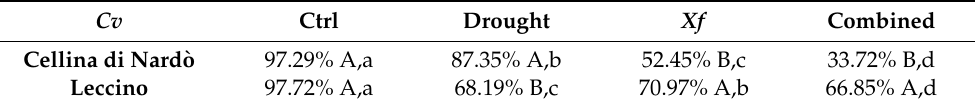
Table 2. Relative water content (RWC, %) values of Cellina di Nard ò and Leccino olive trees under different conditions: control (Ctrl), water deficit (Drought), Xylella fastidiosa ( Xf ), and a combination of water deficit and Xf (Combined). Different letters correspond to statistically different means (upper case between rows, lower case between columns) carried out using ANOVA followed by the Tukey-HSD post hoc